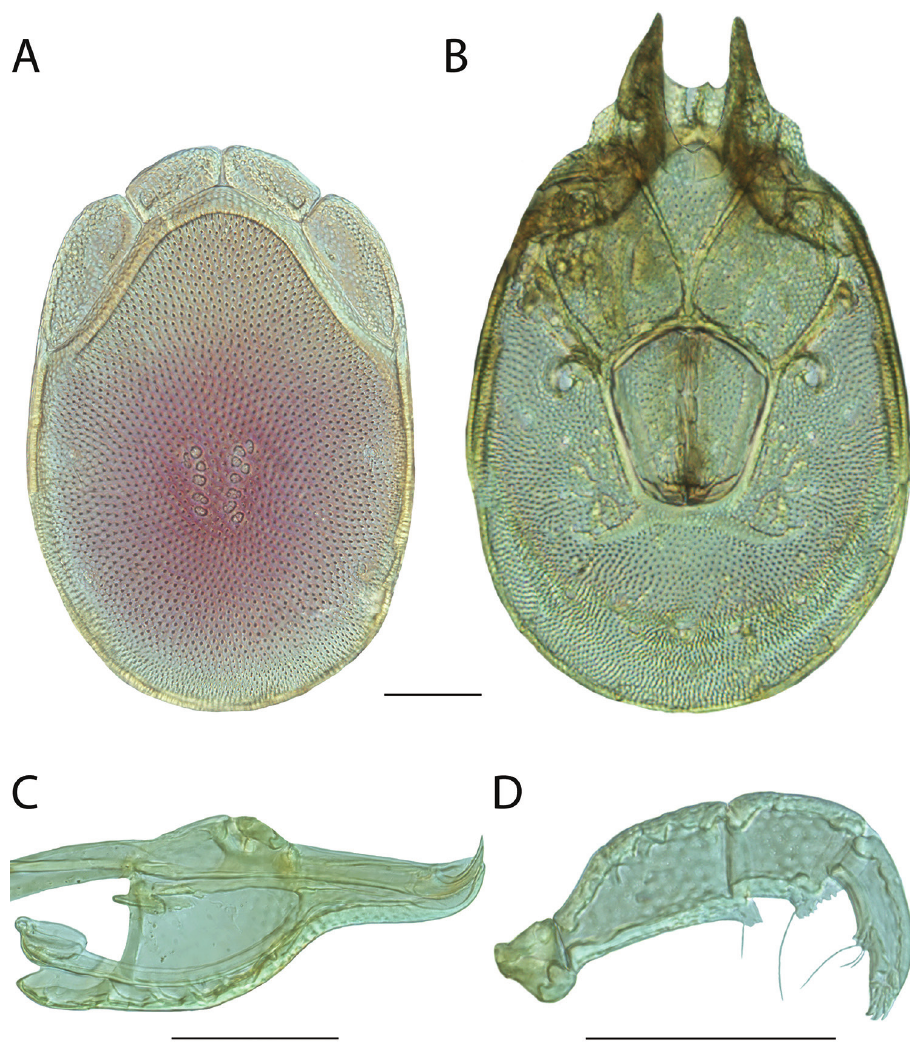
Figure 182. Torrenticola pacificensis sp. n. female: A dorsal plates B venter (legs removed) C subcapitulum D pedipalp (setae not accurately depicted). Scale = 100